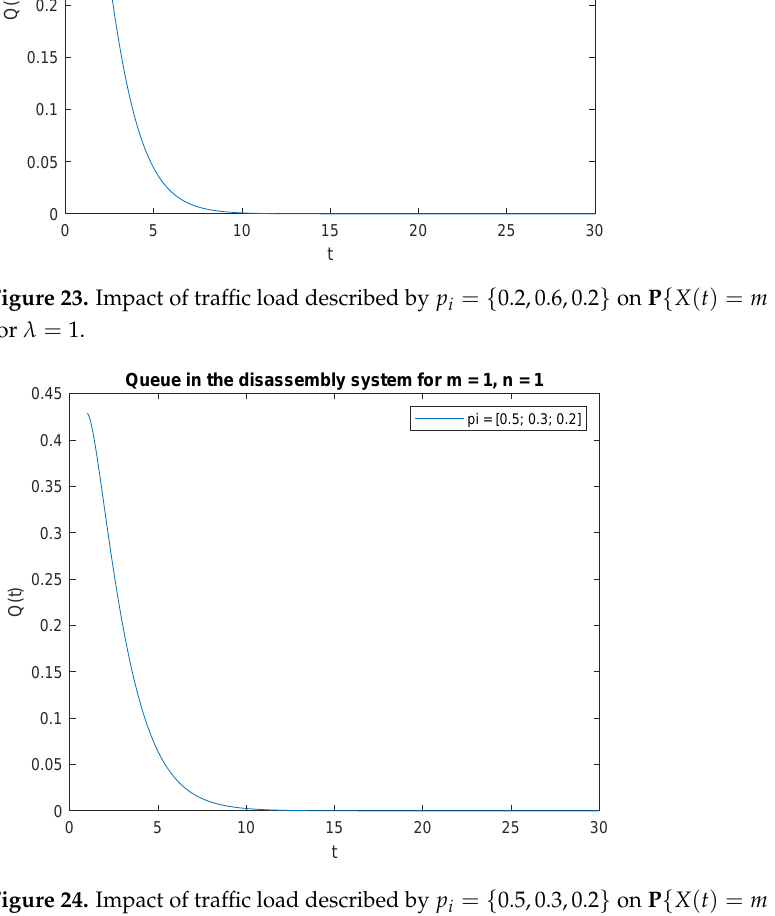
Figure 24. Impact of traffic load described by p i = { 0.5,0.3,0.2 } on P { X ( t ) = m = 1 | X ( 0 ) = n = 1 } for λ =